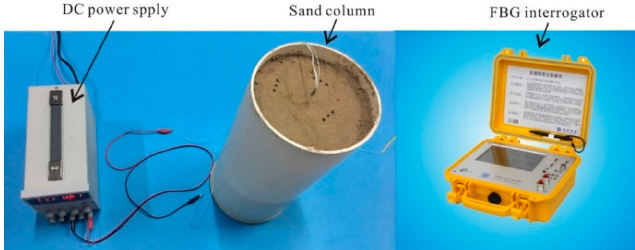
Figure 3. Photographs of the laboratory calibration devices.